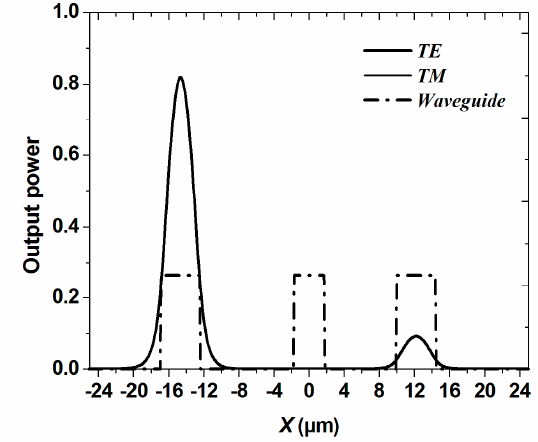
Figure 7. The waveforms of output power guide 1, guide 0 and guide 2 for TE and TM modes with splitting ratio 90:10 at wavelength 1.55 µm. The output waveforms for TE and TM modes coincide well.